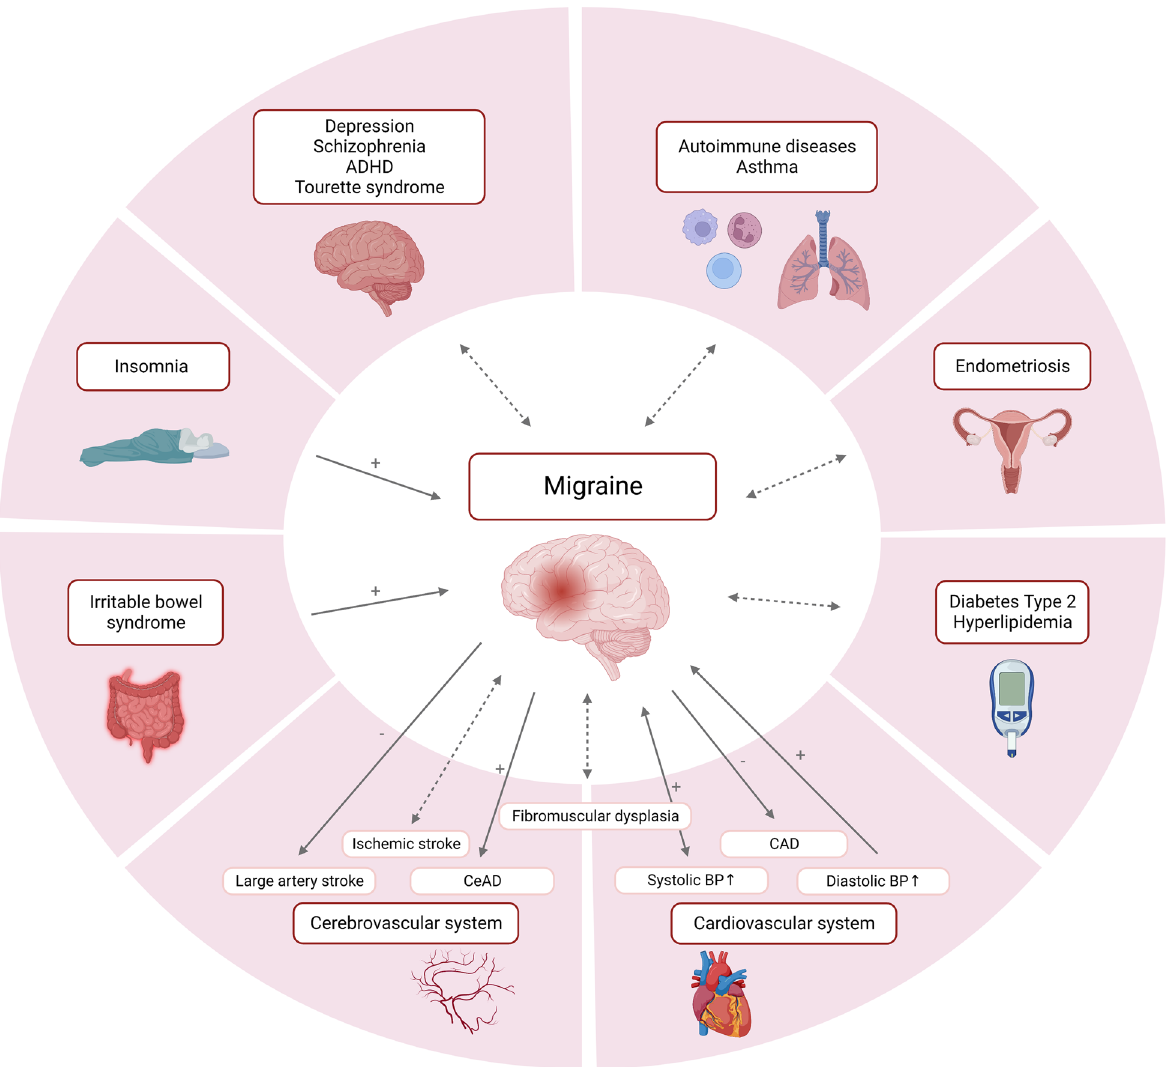
Fig. 3 Shared genetic background of migraine and its comorbid diseases. Genetic relation of migraine and some of its clinically most relevant comorbidities. Dotted arrow: Genetic association or correlation as demonstrated by GWAS or genetic correlation studies. Solid arrow: Causal association of genetic variants as demonstrated by Mendelian randomization studies. , liability to one disease decreases risk for the comorbidity; ADHD, attention deficit hyperactivity disorder; BP, blood pressure; CAD, coronary artery − disease; CeAD, cervical artery dissection. Created with